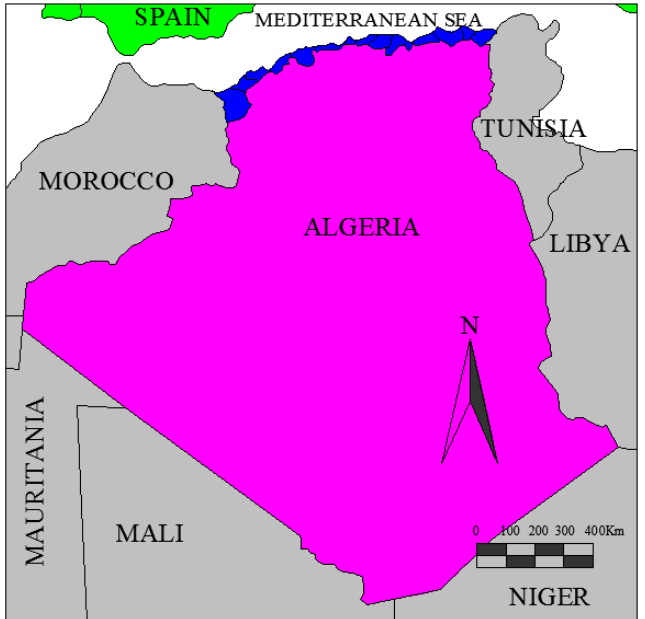
Figure 4. Location of the Algerian shoreline (blue) in Algeria (purple) and Africa (gray). White areas correspond to the seas. Source: made by W.H. using official data.